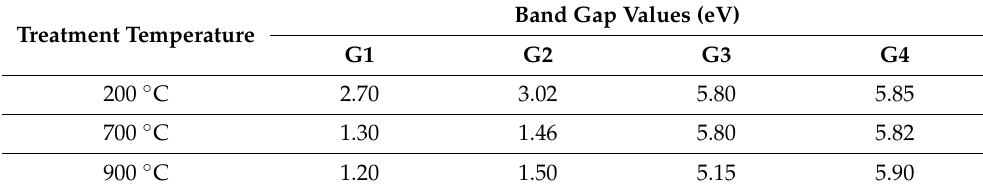
Figure 5. SEM images of heat-treated powders: ( a ) G1-900 °C (×4000), ( b ) G2-900 °C (×4000) and ( c ) G4-900 °C (×20,000).